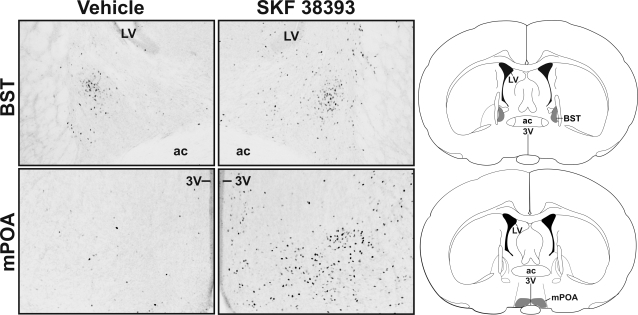
SKF 38393-induced Fos expression within the BST and mPoA.Photomicrographs of SKF 38393-induced Fos expression within the BST and mPOA. The right column shows schematics of the regions pictured. Shaded area indicates regions examined. 3V, third ventricle; ac, anterior commissure; BST, bed nucleus of the stria terminalis; LV, lateral ventricle; mPOA, medial preoptic area.